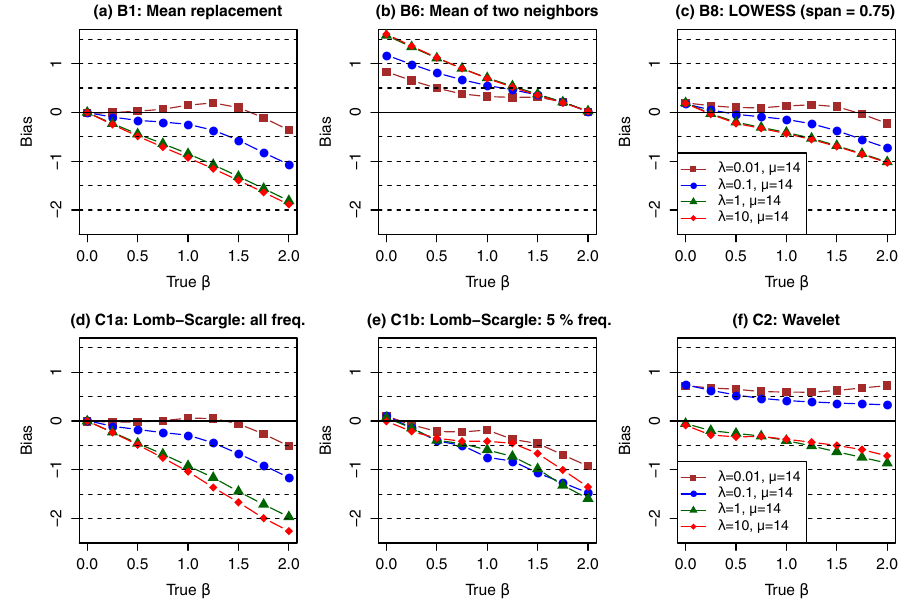
Figure 8. Comparison of bias in estimated spectral slope in irregular data that are simulated with varying prescribed β values (100 replicates), a series length of 9125, and a mean gap interval of 15 (i.e., µ = 14).